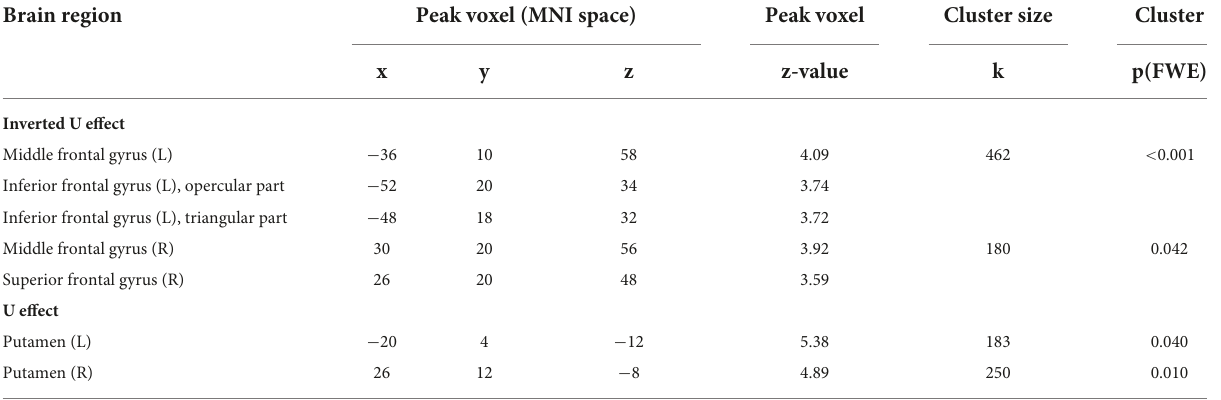
TABLE 1 Summary of contrast-weighted task-based functional connectivity changes. Brain